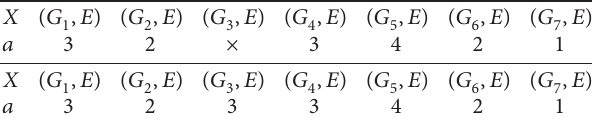
, E ) : i � 1, 2, ... , 7 with respect to attribute a i